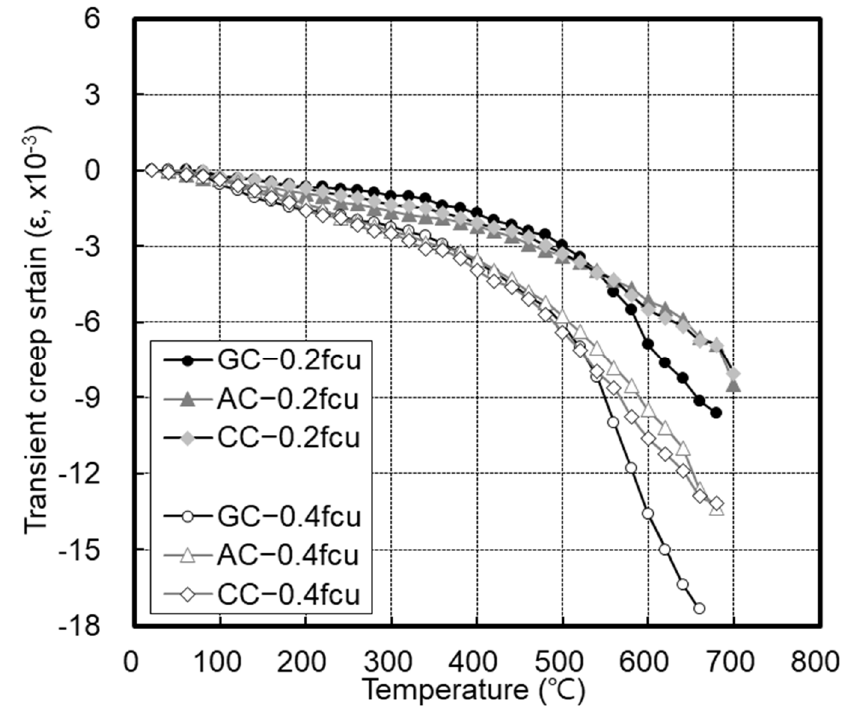
Figure 11. Transient creep